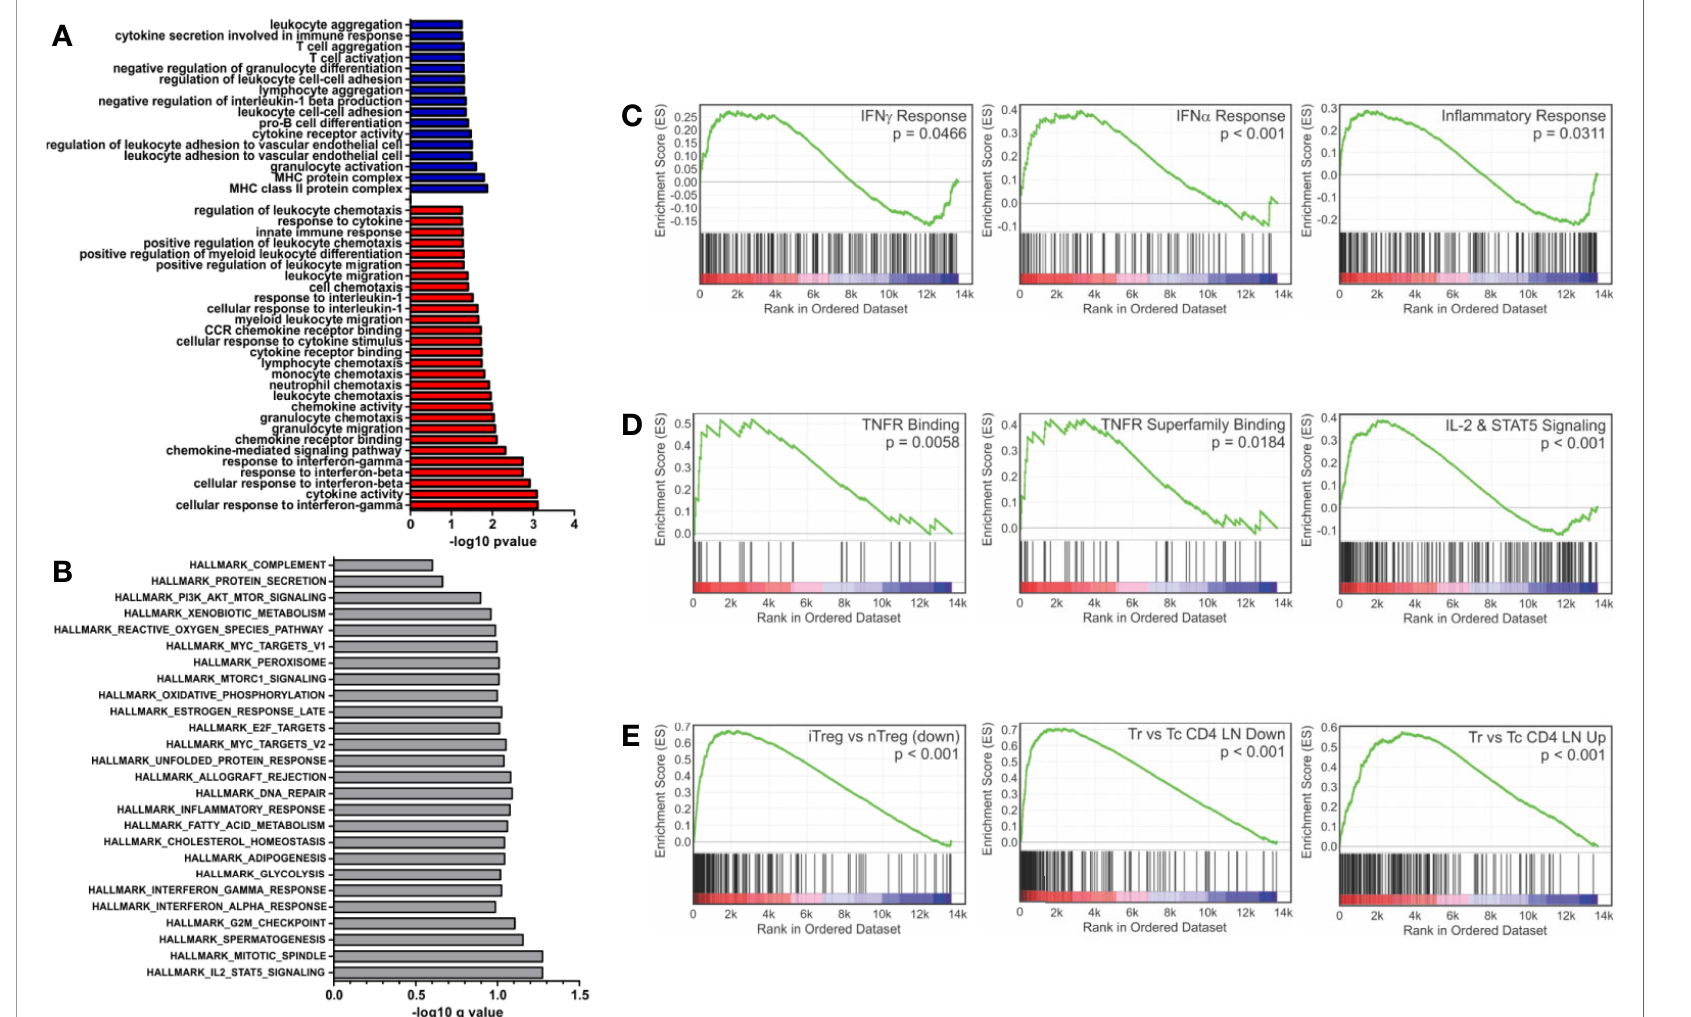
FIGURE 1 | Gene set enrichment analysis of in fl ammatory and interferon related genes. Gene ontology and gene set enrichment analysis were conducted on differentially expressed genes (FDR > 0.05 and log2CPM > 0). (A) Gene ontology analysis of differentially expressed genes increased (red) and decreased (blue) with PSA exposure in CD4 + T cells. GO terms with immunological relevance were extracted (44 terms). Gene ontology terms signi fi cantly associated (P ≤ 0.05) were plotted as − log10 version. (B) Hallmark gene set enrichment analysis of PSA stimulated cells. Gene sets signi fi cantly associated (P ≤ 0.05) were plotted as − log10 of q value. GSEA analysis showing enrichment in (C) IFN- g , IFN- a and in fl ammatory response gene sets, (D) TNF superfamily members and receptors, (E) and gene sets associated with Treg